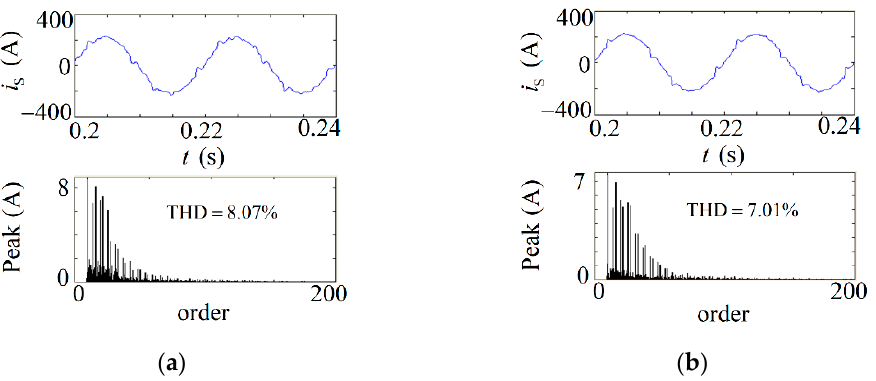
Figure 15. Variation of grid current with ω r and T ( a ) when C = 270 µ F; ( b ) when T = 1/32 kHz. In order to verify the practical performance of the shunt virtual resistor method, corresponding experiments were conducted on the experimental prototype shown in Figure 16. The related parameters were the same as those of the previous